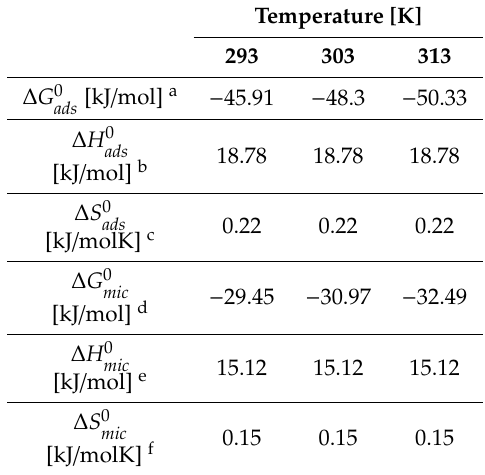
) and standard ads ), standard mic